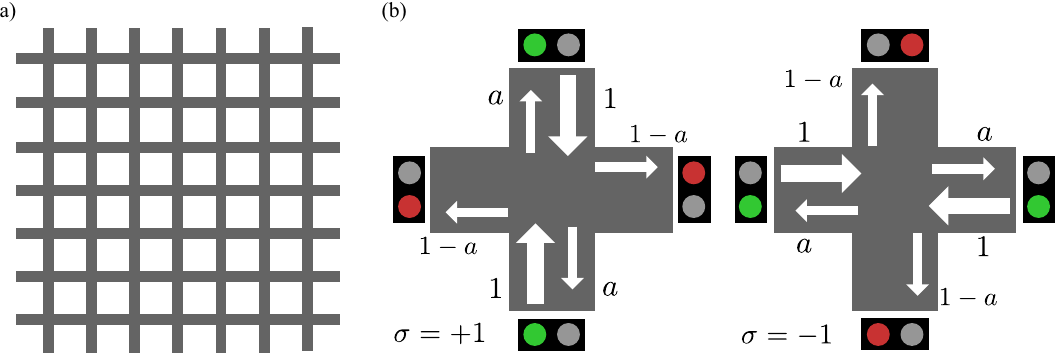
Figure 1. Traffic signal model. ( a ) Grid pattern of roads. ( b ) The two states of traffic signals at each intersection. In the case of σ = + 1 , the vehicles coming from the horizontal direction stop, and the vehicles coming from the vertical direction go straight at the rate of a , turn right at the rate of ( 1 − a )/ 2 , and turn left at the rate of ( 1 − a )/ 2 . The rate 1 − a shown for the horizontal direction is the sum of the vehicles from the two vertical directions. In the case of σ = − 1 , the roles of the vertical and horizontal directions are reversed. This problem setting is basically following Ref. 39